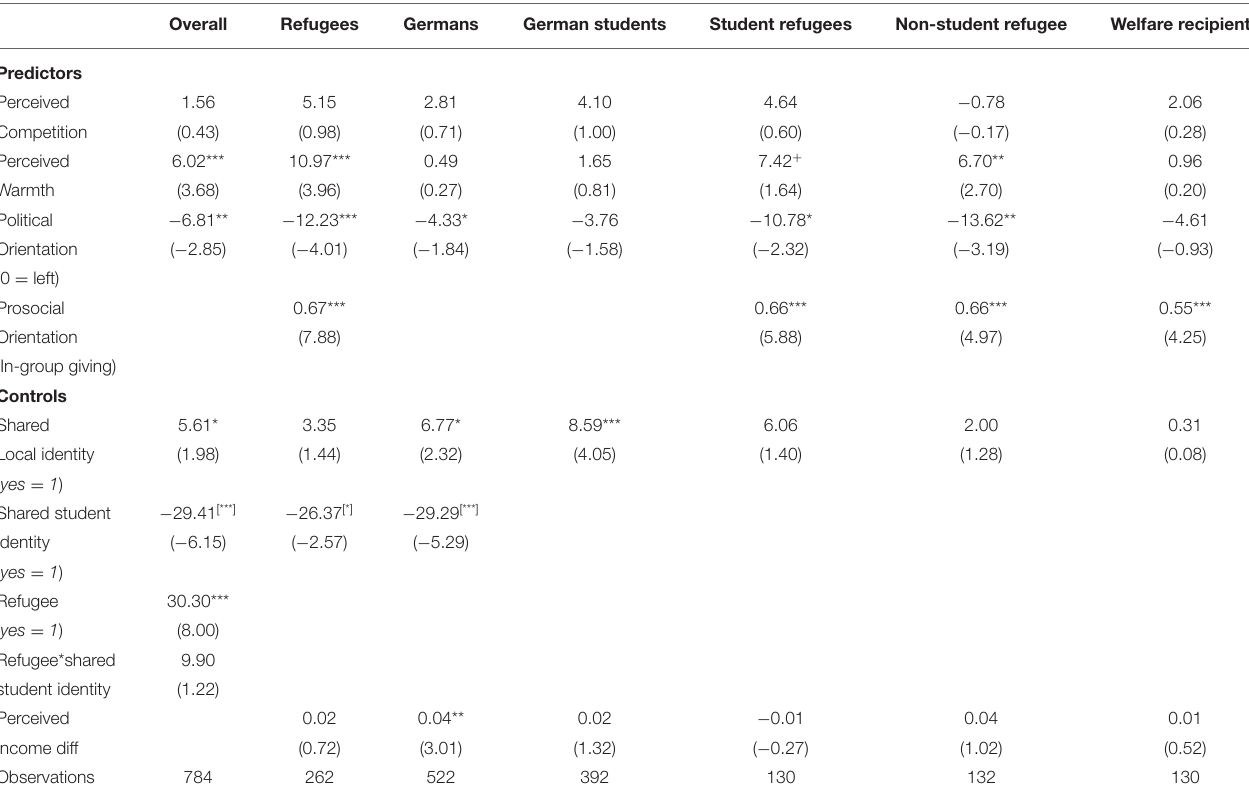
TABLE 3 | Altruistic giving predicted by perceived competition, perceived warmth, political left-wing orientation and prosocial orientation for the overall (all receivers, column 1), refugee (student and non-student refugees, column 2) and German (German students and social welfare recipients) sample and for each individual receiver group separately (column